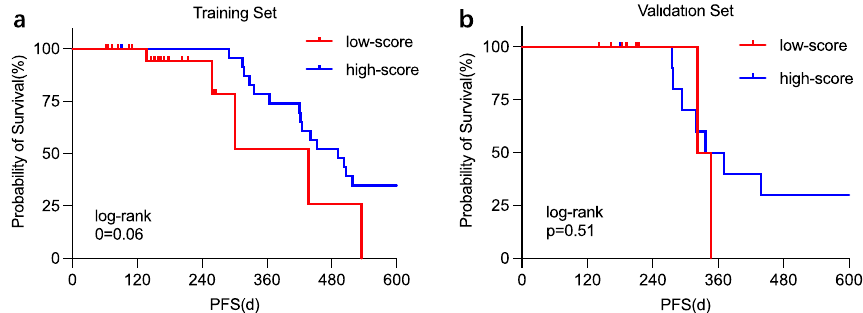
Figure 5. Kaplan–Meier overall survival curve analysis in training ( a ) and validation set ( b ). ( a ) Probability of PFS for high-score (median = 493 day) and low-score (median = 297 day) in training set. ( b ) Probability of PFS for high-score (median = 347 day) and low-score (median = 337 day) in validation set. The CT-based radiomics and clinical score was defined as high (> 0) or low (≤ 0), score = Features * β Model Coefficient + Bias Model